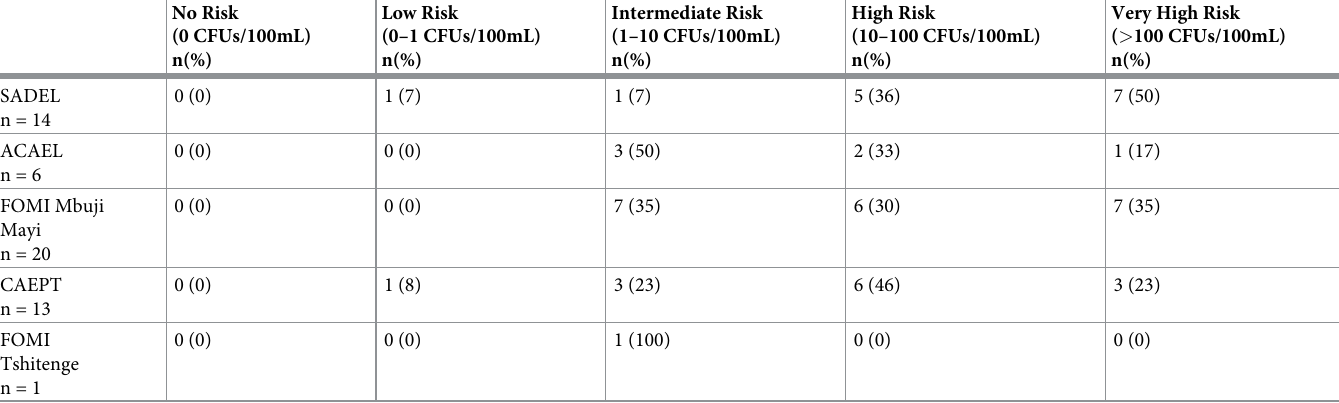
Table 6. Percentage of thermotolerant coliform counts within each World Health Organization risk threshold, with samples from functional WSP collection points.. No Risk (0 CFUs/100mL)